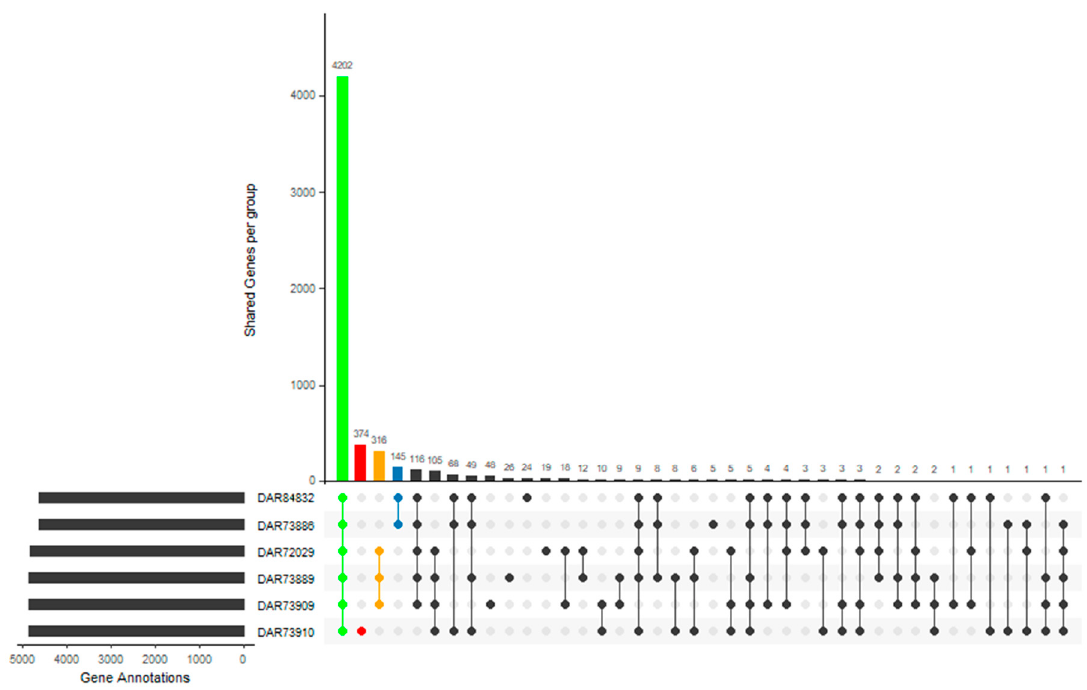
Figure 3. Visualisation of intersecting gene sets of the genomes sequenced in this study. Coloured linked dots represent isolate groupings for the core genome (green) A* c (red), A* b (orange), and A* a (blue) and the number of genes in that grouping is represented by the bar plots above.